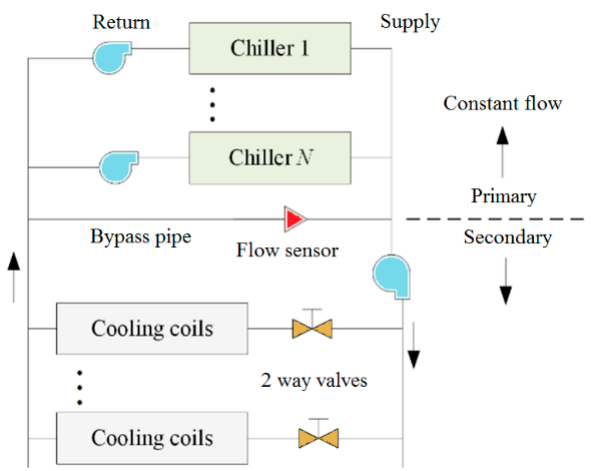
Figure 1. Single-line diagram of a conventional multi-chiller plant.